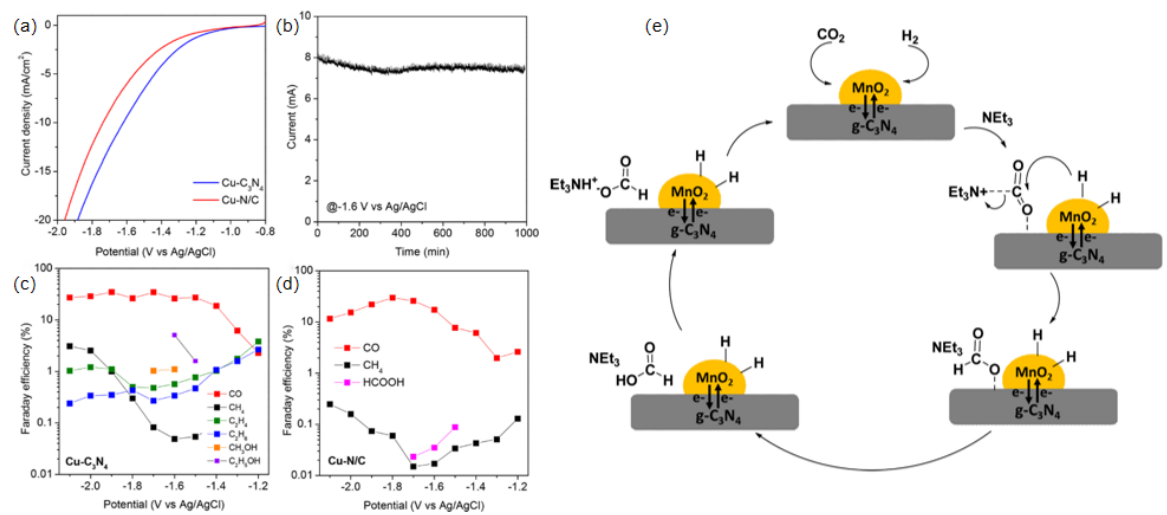
Figure 6. ( a ) CO 2 reduction polarization curves on two electrocatalysts, measured in CO 2 -saturated 0.1 M KHCO 3 ; ( b ) CO 2 reduction stability test on Cu-C 3 N 4 electrocatalyst; the Faradaic efficiencies of several products on Cu-C 3 N 4 ( c ) and Cu-NC ( d ) at different overpotentials, reprinted with permission from ref. [78], Copyright © 2023 American Chemical Society; ( e ) a probable reaction pathway for the hydrogenation of CO 2 to produce formic acid/formates over a MnO 2 /g-C 3 N 4 catalyst,